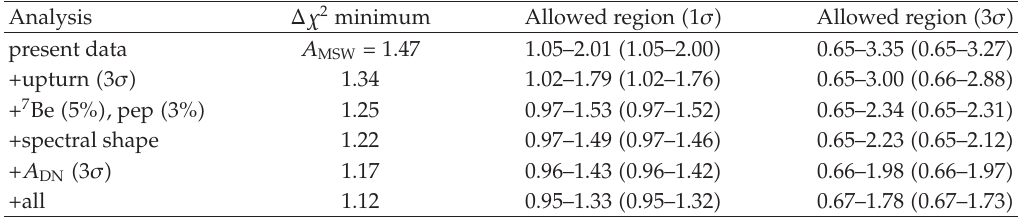
Table 2: The Δ χ 2 minimum of A MSW , the allowed regions of A MSW at 1 σ , and 3 σ CL are shown in the first, second, and third columns, respectively, for the analyses with the currently available data (cid:6) first row (cid:7) , the one with spectrum upturn of 8 B neutrinos at 3 σ added to the current data (cid:6) second row (cid:7) , the one with 7 Be and pep neutrinos with 5% and 3% accuracies, respectively, added to the current data (cid:6) third row (cid:7) , the one with the new spectral information in the second and the third rows added to the current data (cid:6) fourth row (cid:7) , and the one with day-night asymmetry of 8 B neutrinos at 3 σ added to the current data (cid:6) fifth row (cid:7) . The last row presents results of global analysis with all the above data. The numbers in parentheses imply the ones obtained with improved knowledge of θ 12 ; see text for